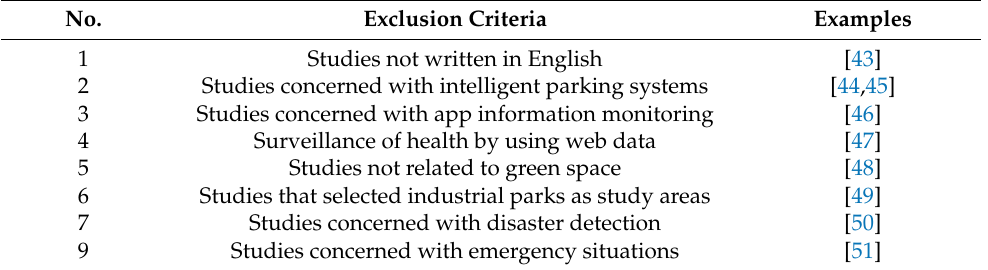
Table 2. Literature screening exclusion